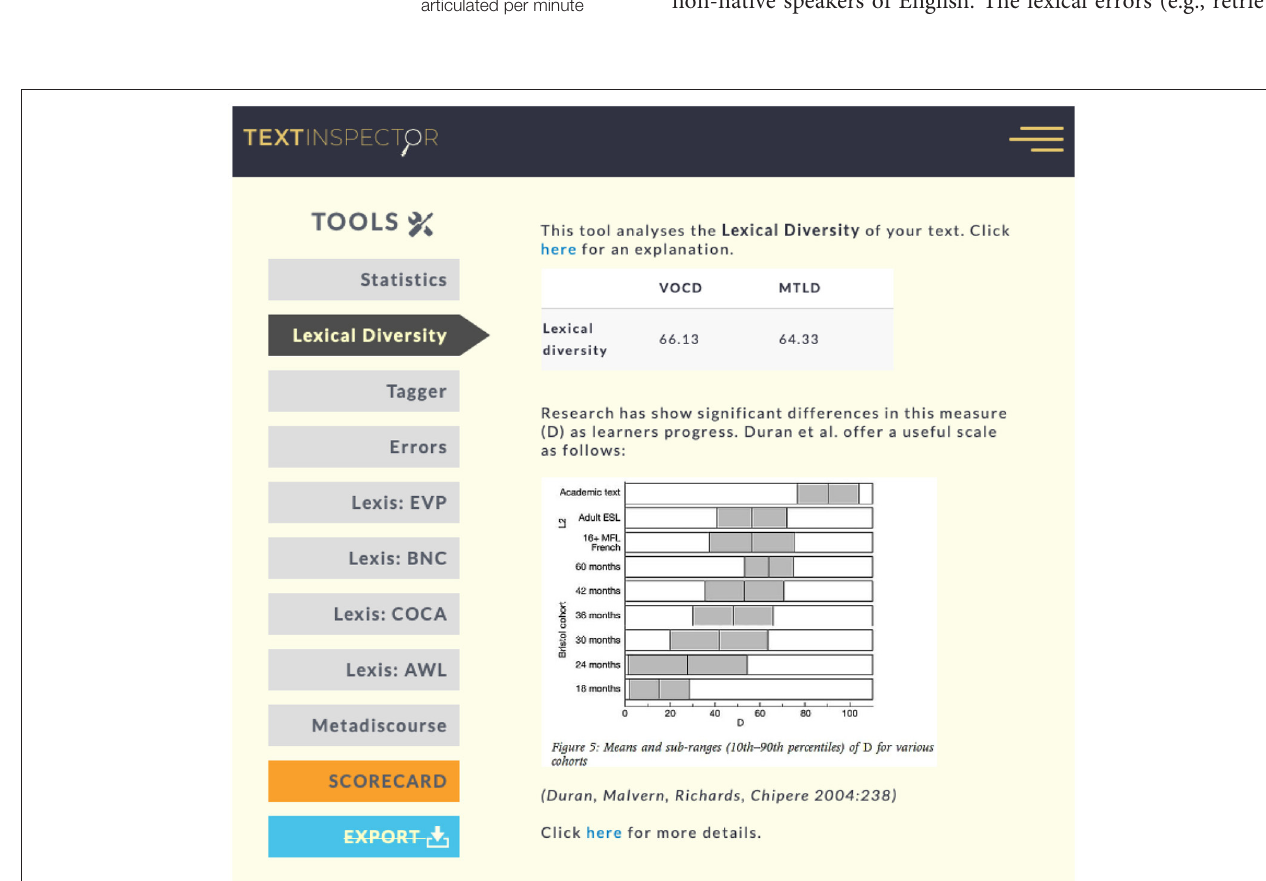
FIGURE 3 | Screen capture of TextInspector. Reproduced with